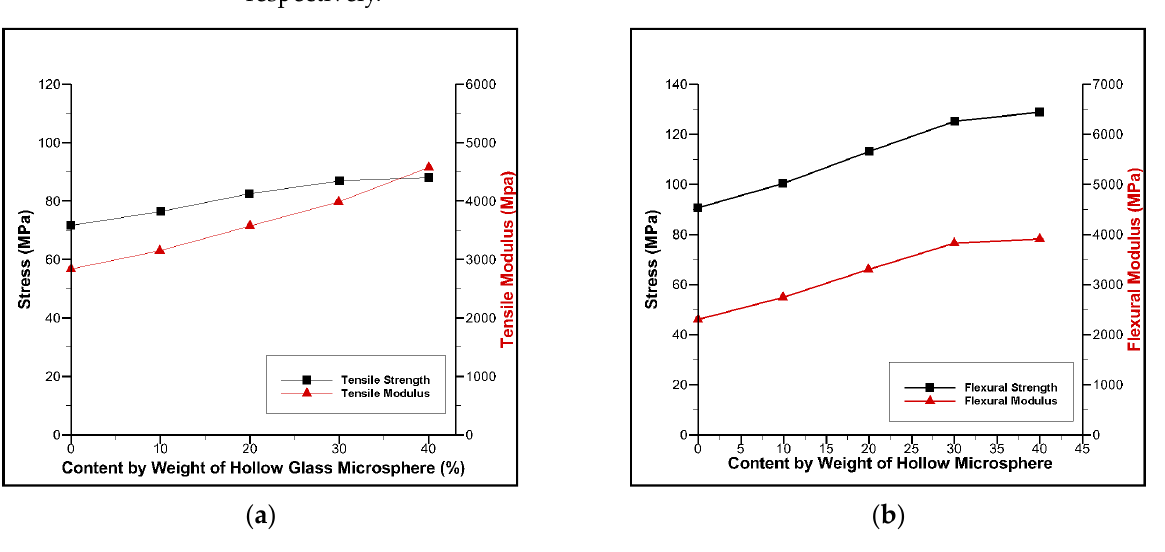
Figure 2. ( a ) Tensile test results. ( b ) Flexural test results [28].